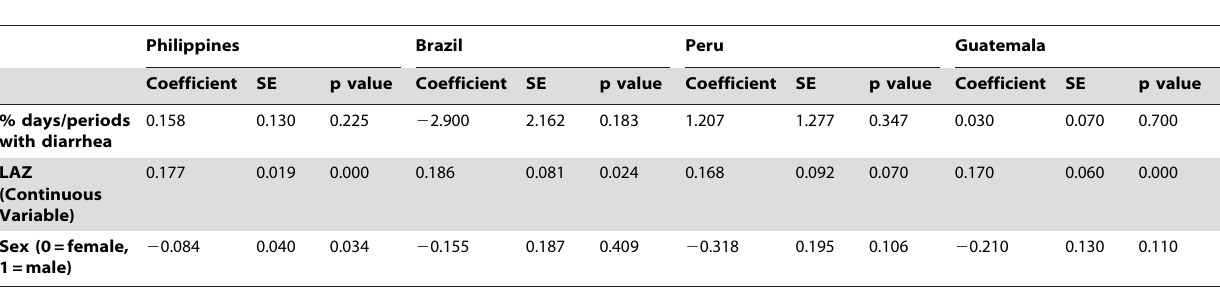
Table 2. Results of country-level linear regression models to determine the association of diarrhea on cognition. a,b,c,d,e